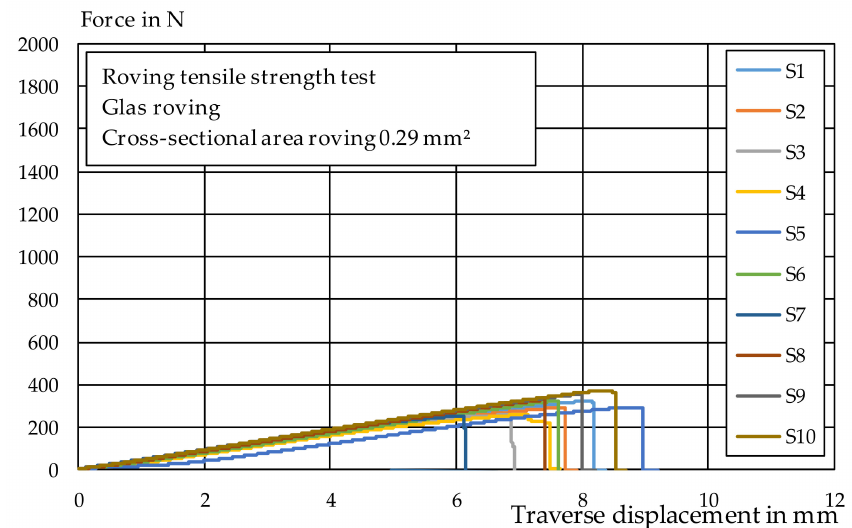
Figure A2. Roving tensile strength test, glass